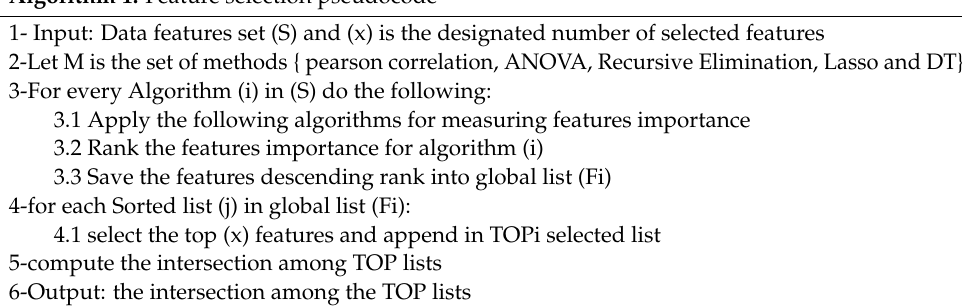
Algorithm 1. Feature selection